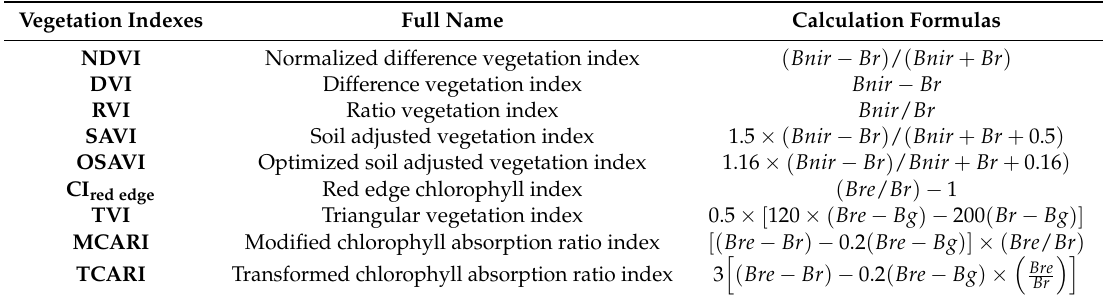
Table 2. Vegetation